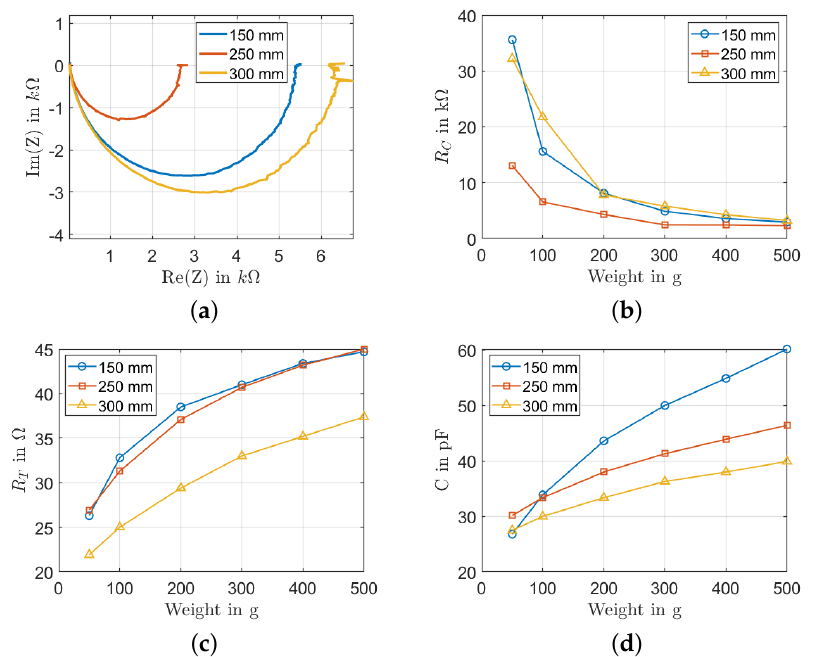
Figure 9. Influence of the squeegee height: ( a ) Nyquist plot at a load of 300 g; ( b ) R C change with different loads; ( c ) R T change with different loads; ( d ) C change with different